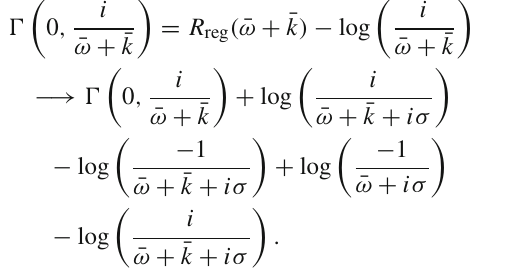
in the lower complex half plane, which is a purely technical choice without unambiguous physical